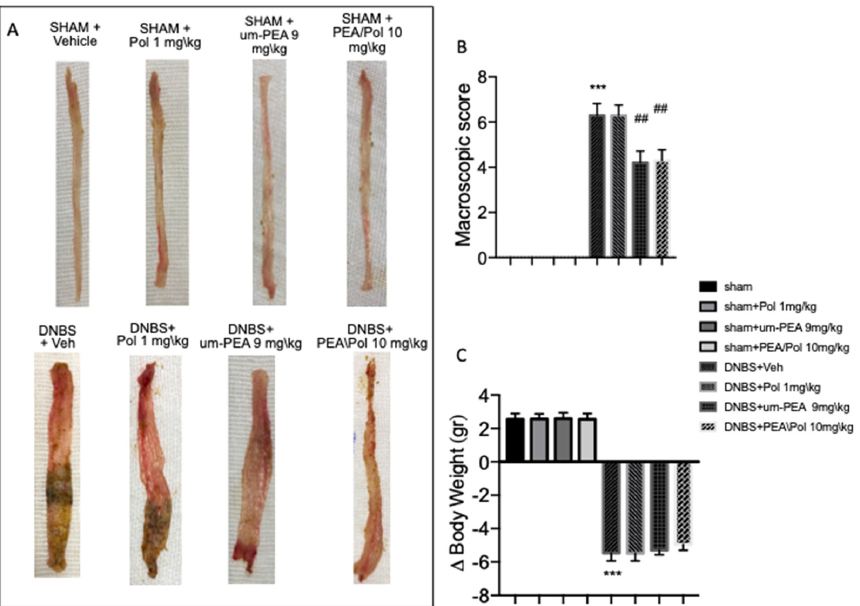
Figure 1. The effects of palmitoylethanolamide/polydatin (PEA/Pol) on macroscopic damage and body weight after four days of Dinitrobenzene sulfonic acid (DNBS)-injection. Macroscopic damage in sham, sham+Pol, sham+ultramicronized PEA (um-PEA), sham+PEA/Pol, DNBS+vehicle (Veh), DNBS+Pol, DNBS+um-PEA, and DNBS+PEA/Pol groups ( A ). Macroscopic score ( B ). Body weight ( C ). Values = means ± SEM of six animals in each group; *** p < 0.001 vs. sham; ## p < 0.01 vs. DNBS.